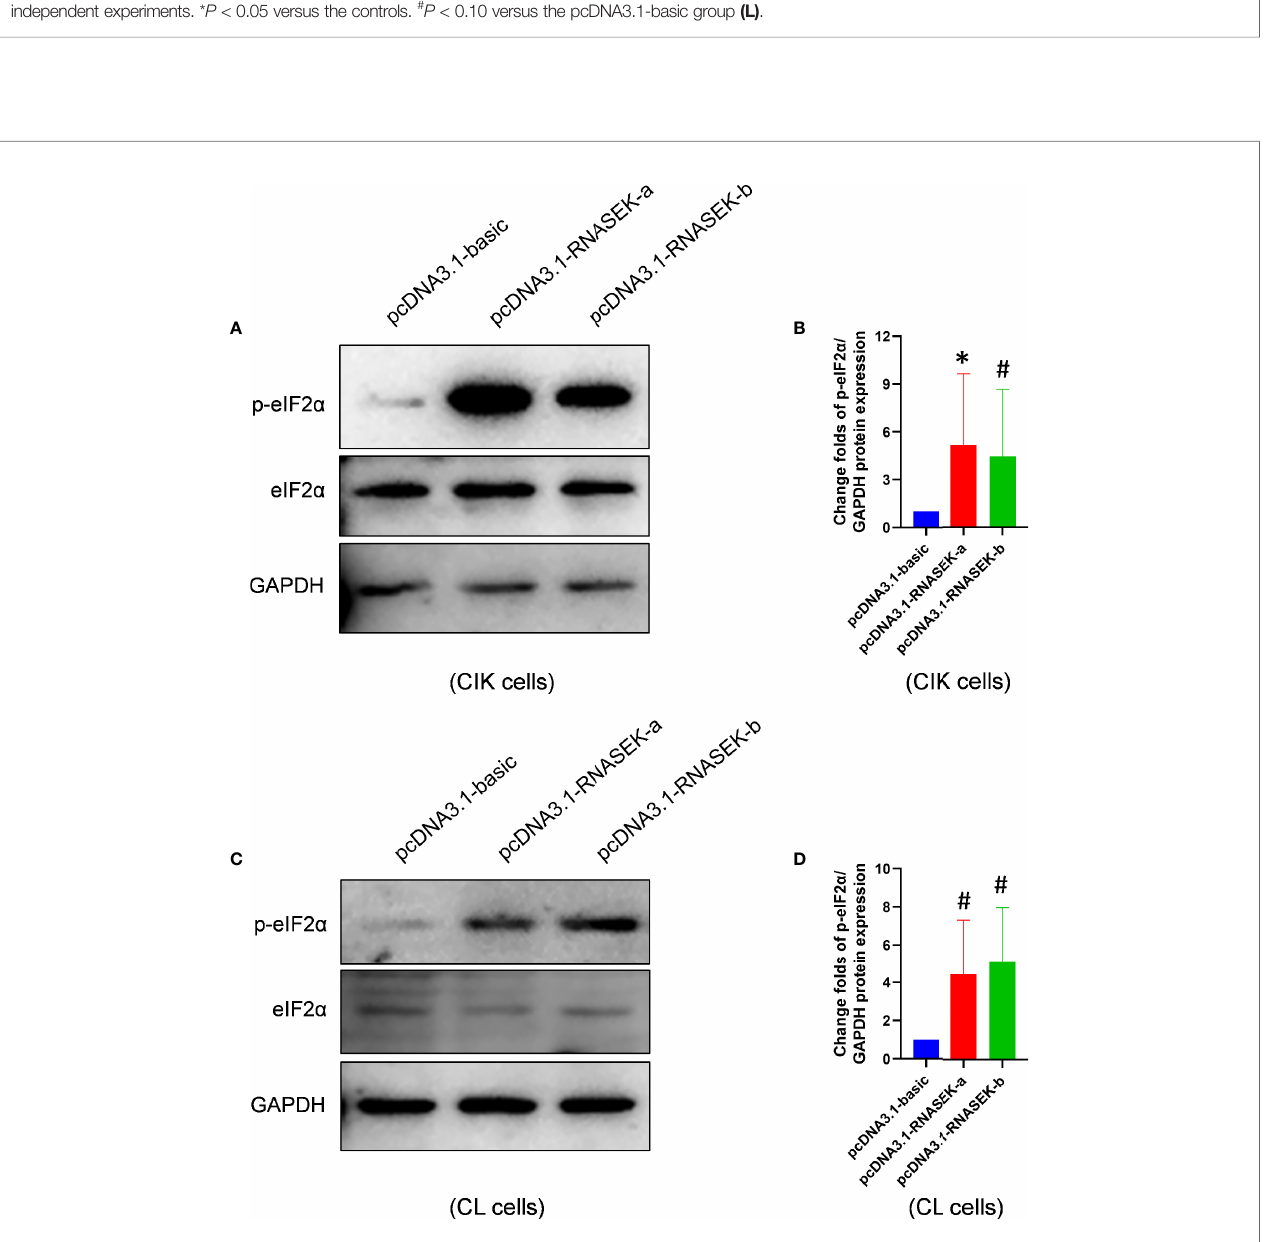
FIGURE 5 | Grass carp RNASEK-a and -b individually promote cell apoptosis. (A – D) In CIK (A, B) and CL (C, D) cells, overexpression of RNASEK-a (A, C) and -b (B, D) individually increased Bax/Bcl-2 mRNA ratio assessed by using qRT-PCR in triplicate. (E, F) Both RNASEK-a and -b overexpression increased DNA fragmentations (indicated with red arrows) shown by agarose gel electrophoresis in CIK (E) and CL (F) cells. (G, H) The pro-apoptosis effects of RNASEK-a (G) and -b (H) overexpression on CIK cells were assessed by TUNEL staining. Images were obtained under 100× magni fi cation by using an inverted fl uorescence microscope (green, TUNEL-positive apoptotic cells marked by red arrows; scale bar, 100 m m). (I, J) Five views representing (G, H) were randomly selected to calculate statistical signi fi cance, respectively. (K, L) In CO cells, the pro-apoptosis effects of both RNASEK-a and -b overexpression were evaluated by fl ow cytometry (K) , where the change folds of the proportion of apoptotic cells marked by Annexin V-FITC are shown ( n = 3; the control data were normalized to 1) (L) . Overexpression of RNASEK-a and -b was performed via transfection of relative recombinant plasmids, including pcDNA3.1-RNASEK-a, pcDNA3.1-RNASEK-b, pEGFP-RNASEK-a, and pEGFP-RNASEK-b. Cell type is indicated in each image. The relative normalized mRNA expression of genes was obtained by using the 2 − DD CT method with b -actin as an internal control (A – D) . Bax/Bcl-2, the ratio of relative normalized mRNA expression of Bax to that of Bcl-2 . The controls consist of pcDNA3.1-basic (A, B, G – L) and pEGFP-C1 (C, D) . All values are mean ± SD. The results are representative of three